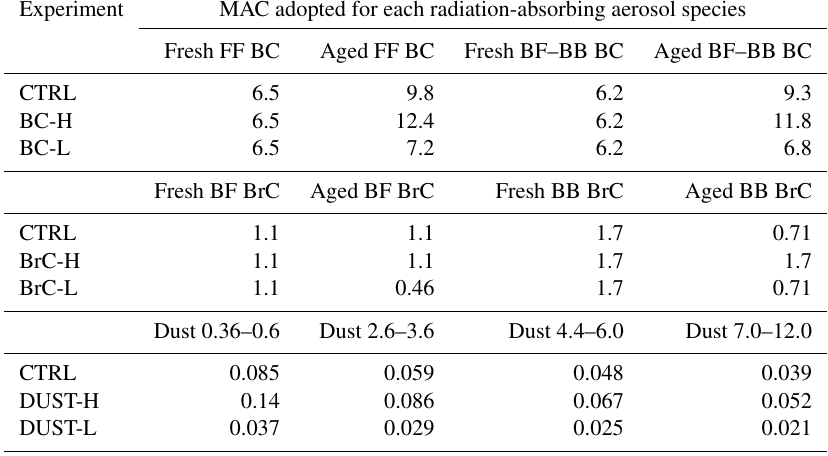
Table 2. Summary of the MACs in the visible band 1 used in the experiments. The units are in m 2 g − 1 .